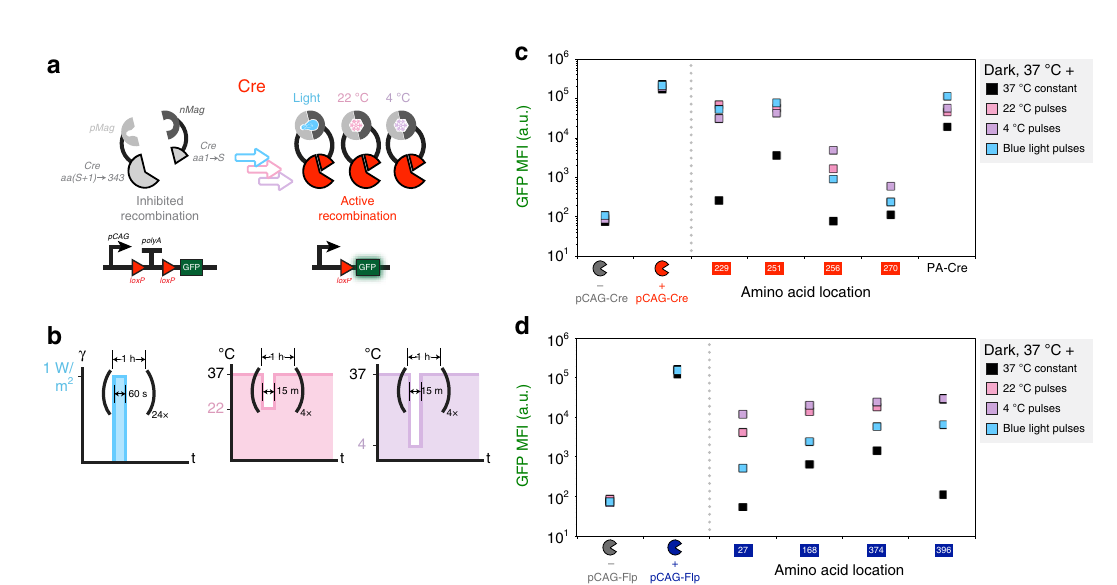
Fig. 3 Light- and temperature-inducible recombinases. a A schematic showing a split Cre fused to nMag and pMag blue light-inducible dimerization domains. b Pulses indicating the changing light (left) and temperature (center and right) conditions. Plots indicate GFP mean fl uorescence intensity (MFI) of various nMag/pMag-tagged split Cre ( c ) and Flp ( d ) recombinases under blue light (blue squares), room temperature (pink squares), and refrigeration (purple squares). Black squares indicate samples treated with constant temperature and dark conditions. PA-Cre indicates expression of a previously developed blue light-inducible Cre recombinase 3 . Inducible recombinases were compared with samples transfected with constitutive recombinases or a blank vector. Error bars of MFI indicate the arithmetic standard error of the mean between three transfected cell cultures. Source data are provided as a Source Data fi